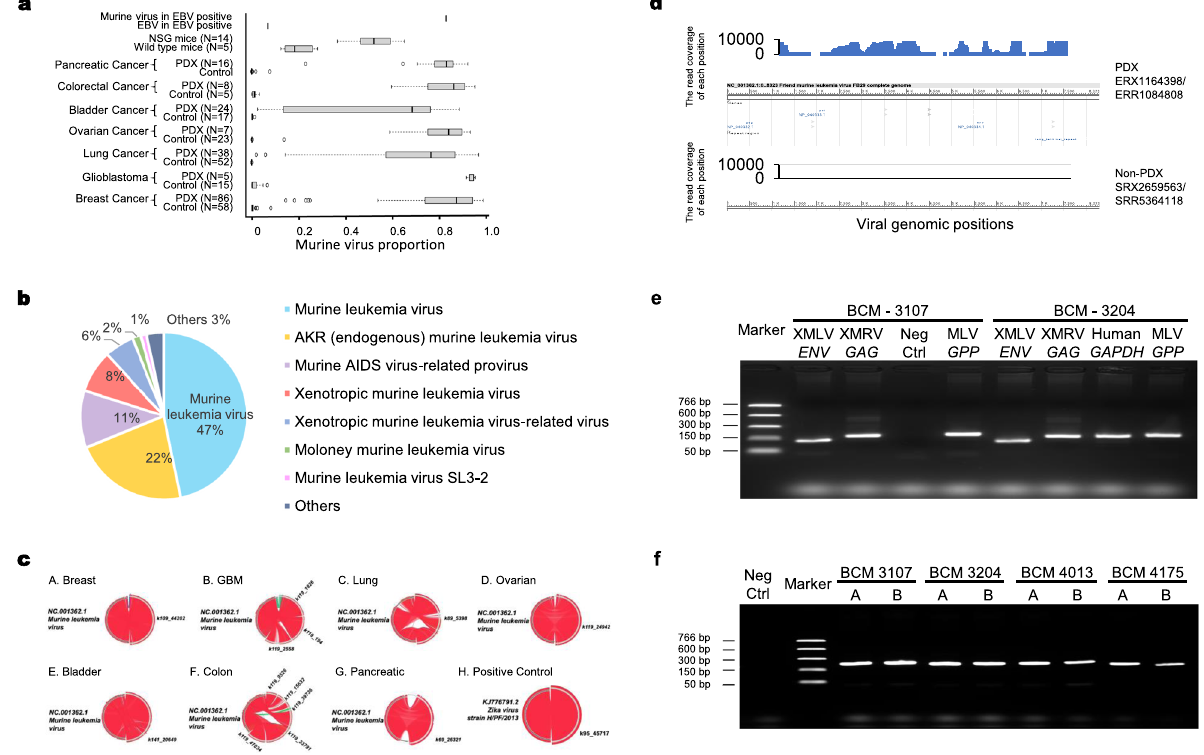
Fig. 1 Abundant murine virus sequence reads found in RNA-Seq data generated from PDX tumor cells. a The proportion of murine virus reads in the total virome in various PDX tumor samples and corresponding controls, wild-type mice and NSG mice. Box limits: 25th and 75th percentiles; center line: median; whiskers: 1.5x interquantile range from box limits; dots: outliers. b Major categories of murine virus as identi fi ed by sequence reads from all PDX cancer samples. c Assembly of full viral genome from RNA-Seq reads. A-G: murine leukemia virus from seven types of PDX. H. Zika-virus-infected human brain organoids as positive control. d Sequence reads from breast cancer PDX (top) but not from non-PDX samples (bottom) cover the entire murine PDX tumor samples. The human GAPDH gene was used as a control to validate the experimental system. Reaction without template is considered as performed twice for each experiment. Source data for ( a , b , e , and f) are provided in Source Data